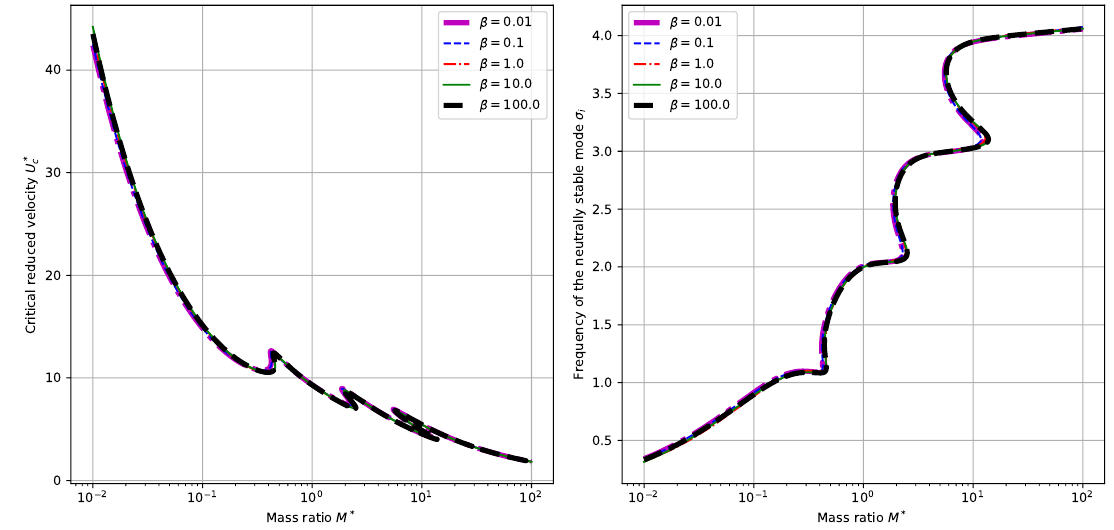
Figure 3. Dependence of the critical reduced velocity U ∗ c ( left panel) and the corresponding neutrally stable frequency σ i ( right panel) upon the mass ratio M ∗ and different values of β . (Here we have α =